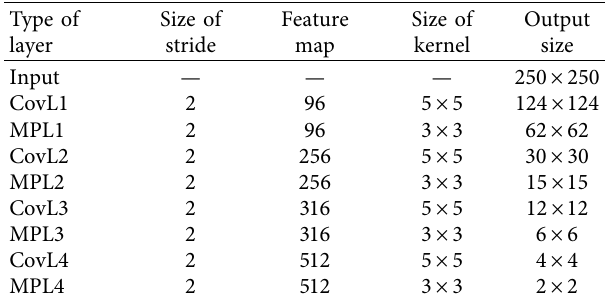
Table 3: CovL and MPL parameters’ setting. Type of